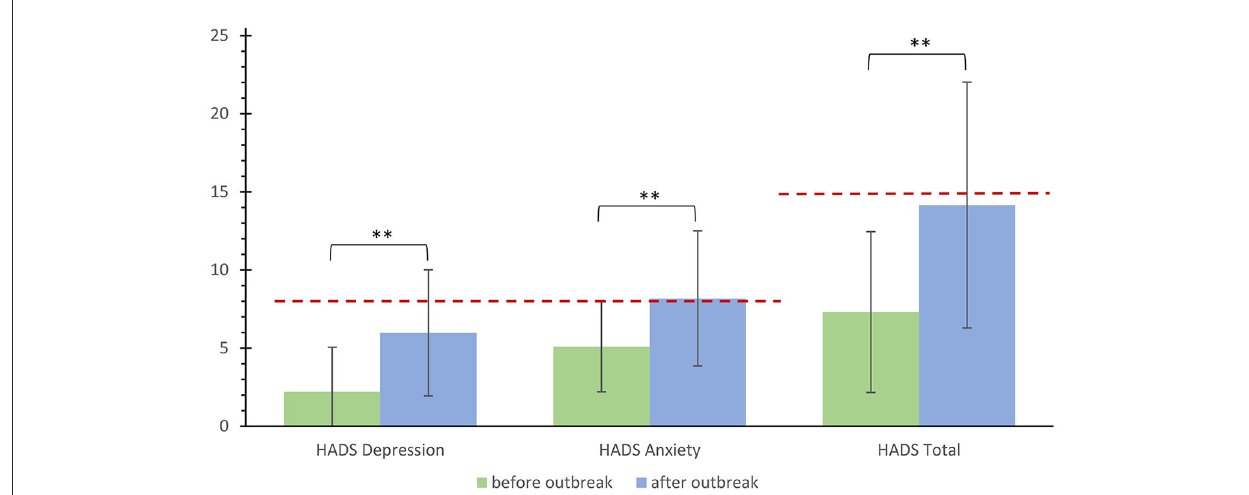
FIGURE3 Change in HADS sum scores. Change in HADS sum scores for the HADS total scale and the anxiety and depression subscales before the outbreak of the pandemic compared to after the outbreak of the pandemic. The dashed line corresponds to the cut-offs for a clinically abnormal score. **Significant differences, p < 0.05.